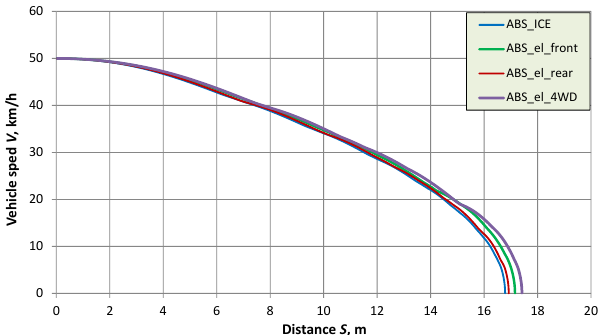
Fig. 9. Distance of stopping the vehicle in braking the vehicle straight ahead on a road with homogeneous high adhesion coefficient [own re- search]